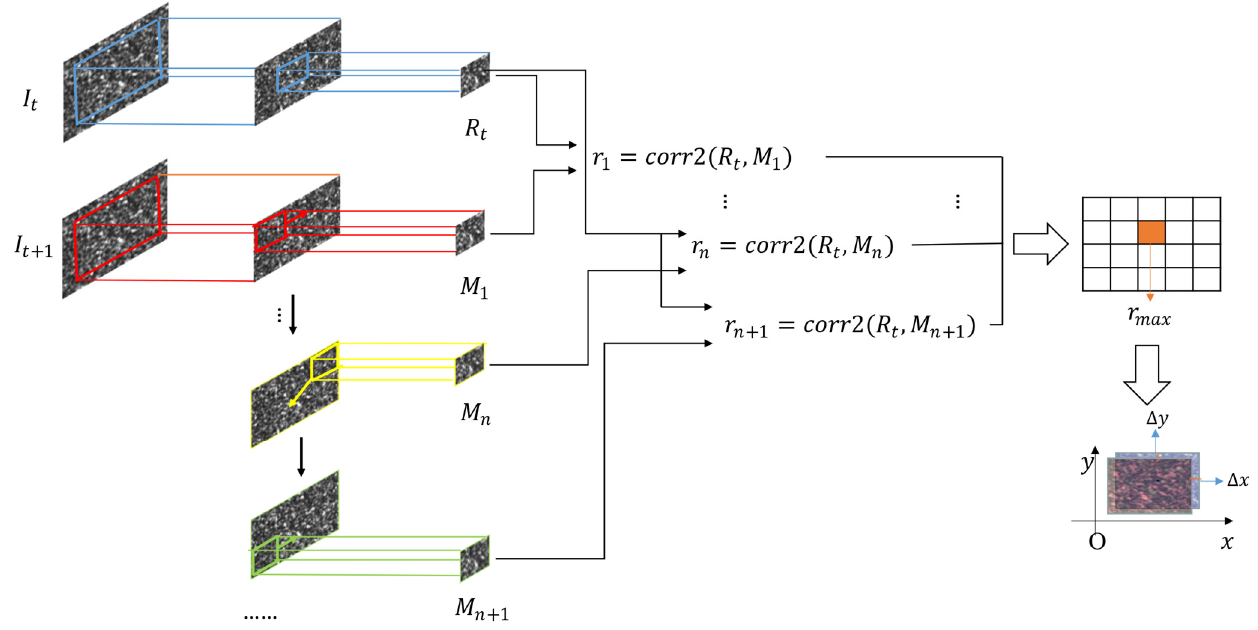
Figure 2. Digital image correlation method.